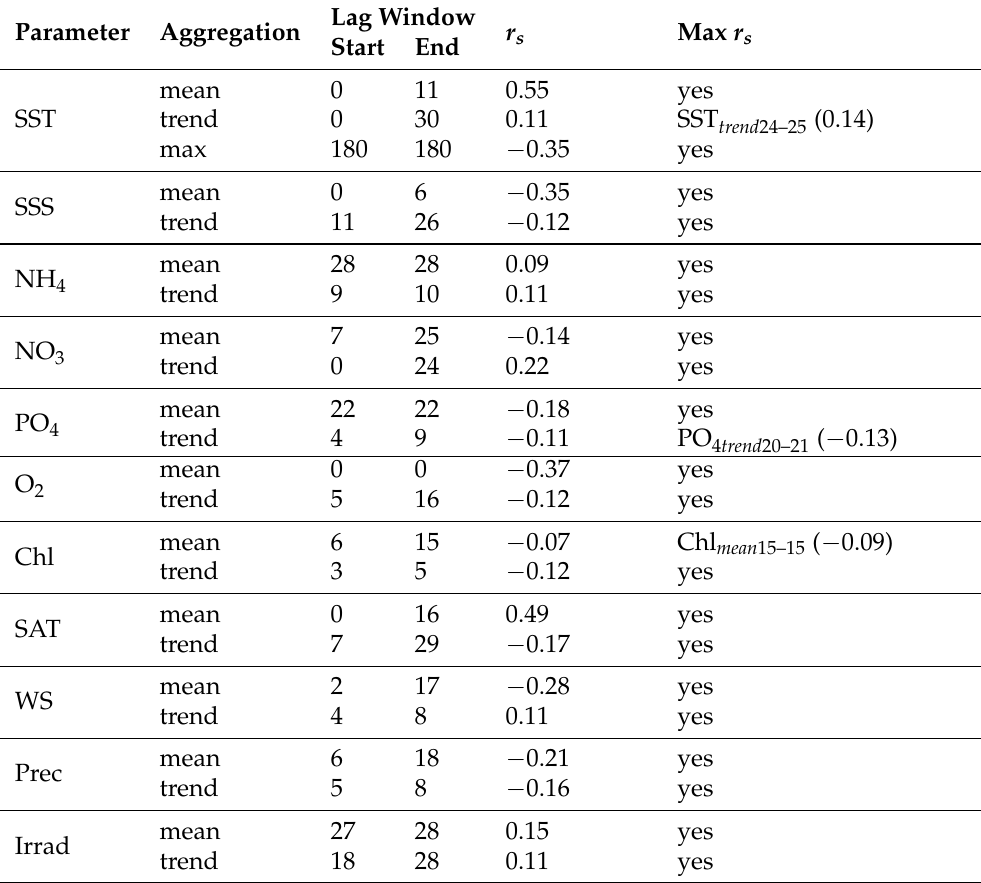
Table A1. Selected lag window for each parameter and aggregation method. r s denotes the Spear- man’s rank correlation coefficient between the environmental parameter and V. vulnificus quantity. In most cases, the lag window with the highest r s was selected. These cases are indicated as “yes” in the column “max r s ”. For all other cases, the column “max r s ” indicates the time window with the highest r s using the format “parameter start – end ( r s